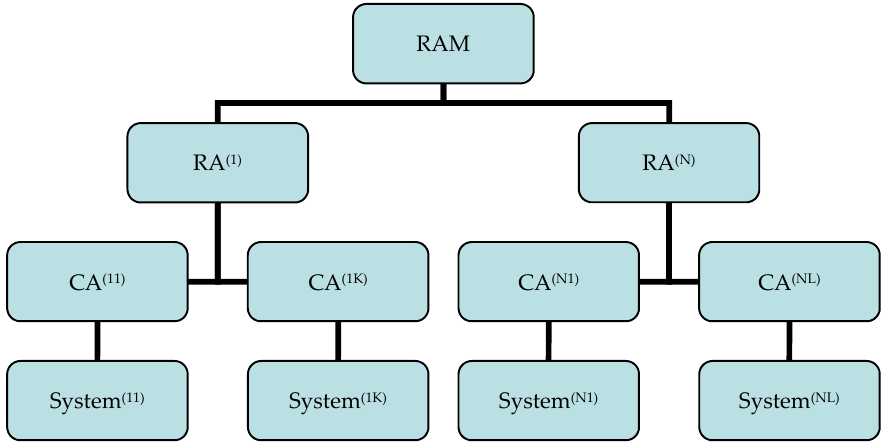
Figure 1. Relation between the Reference Architecture Model (RAM), the Reference Architecture (RA), the Concrete Architecture (CA), and the system.